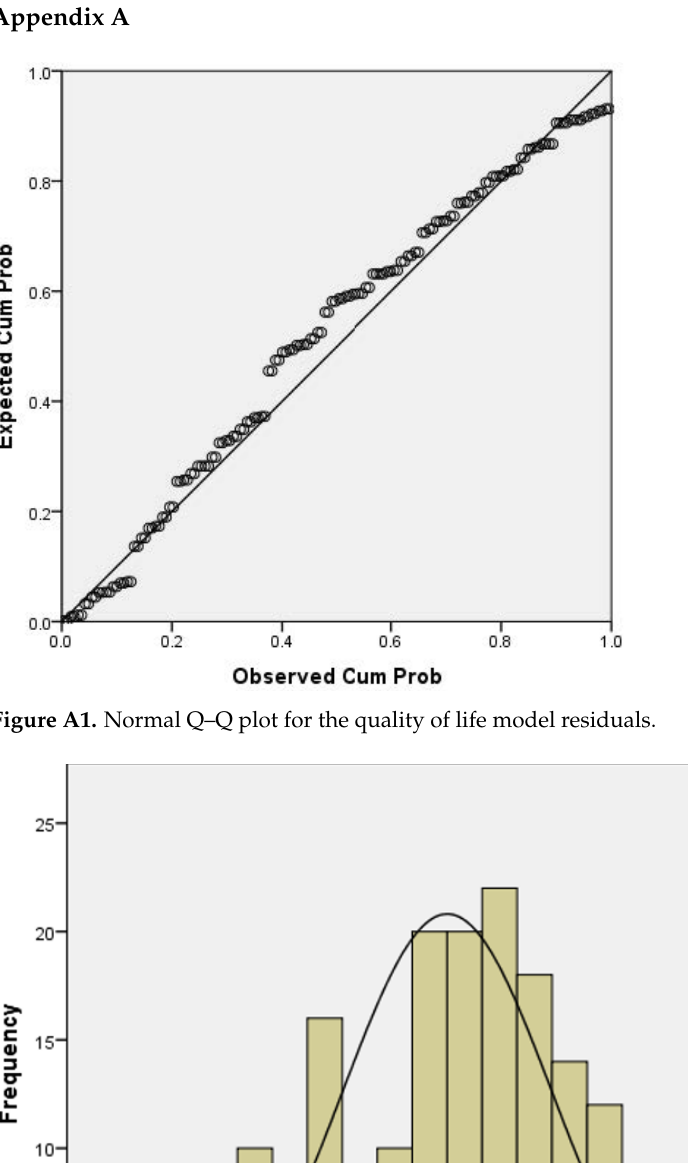
Figure A3. Histogram using mental health as the dependent variable.